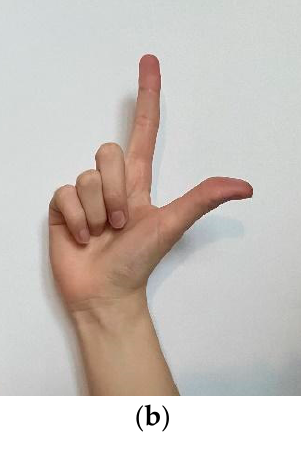
Figure 10. Chart showing samples collected with Cordura covered with silver as a core for the bend sensor.